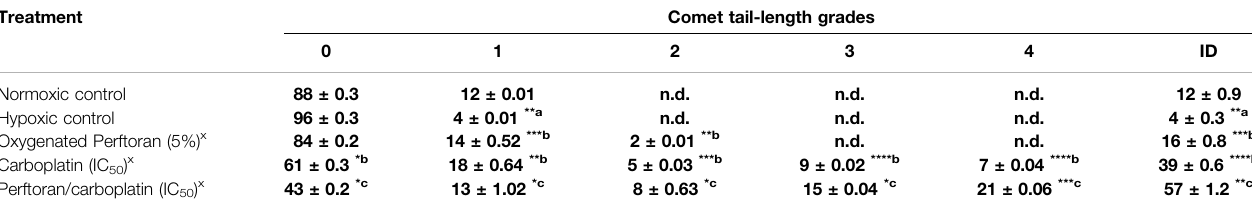
TABLE2| DNAdamageinA549cellsafterdifferenttreatments,asassessedbycometassay.Resultsareexpressedascomet-tail-lengthgrades,inadditiontothedegreeof DNA damage (ID); mean ± standard error ( n =